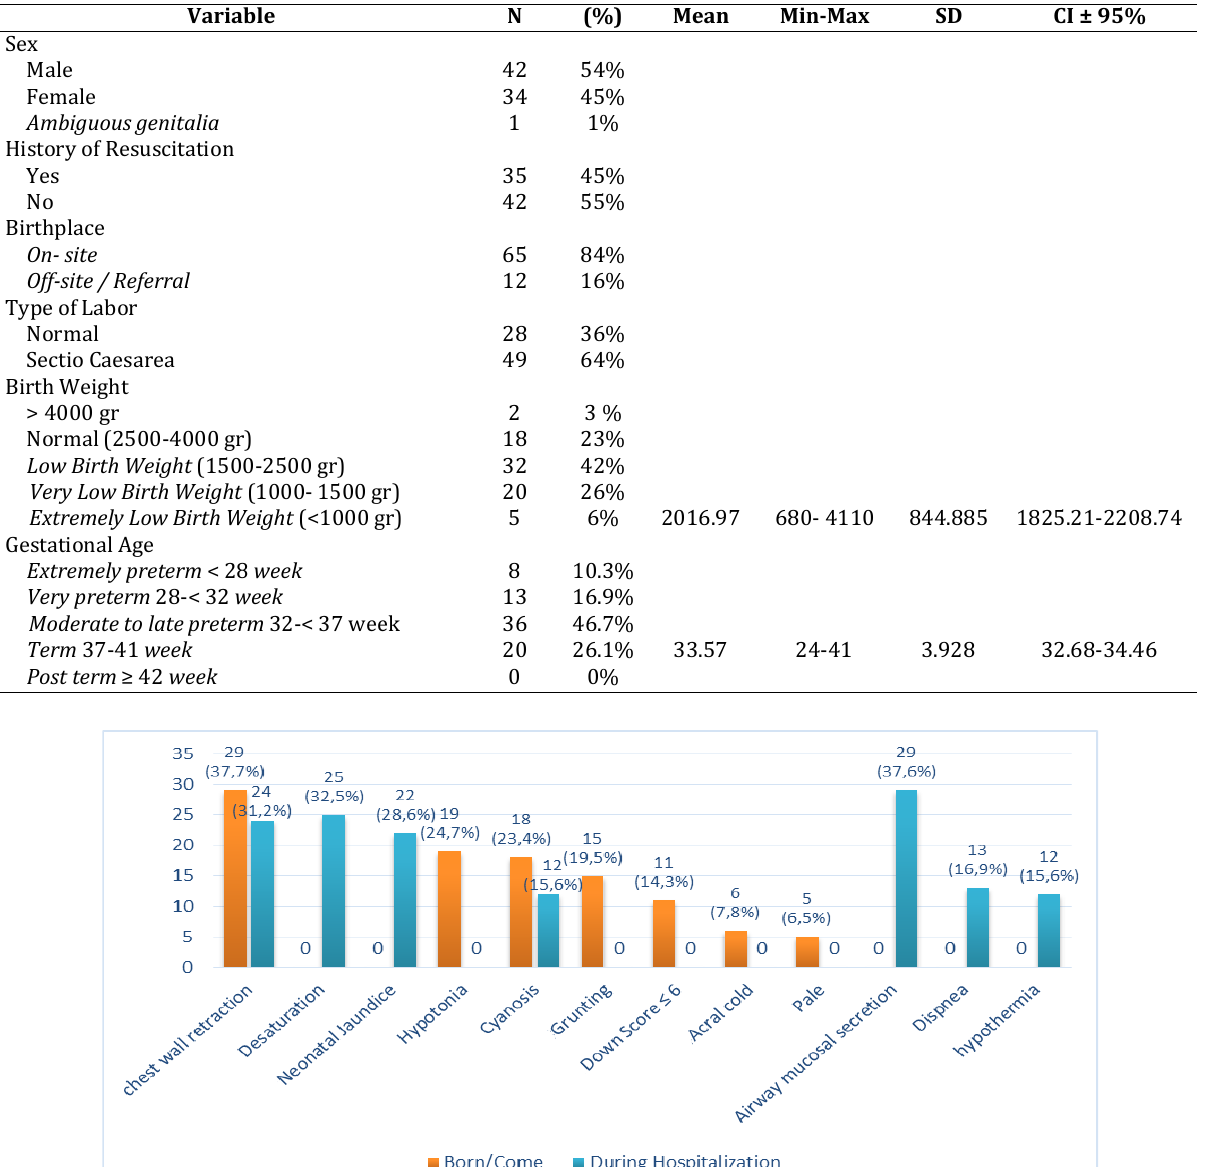
Table 1. The Demographic of Neonates (n=77)